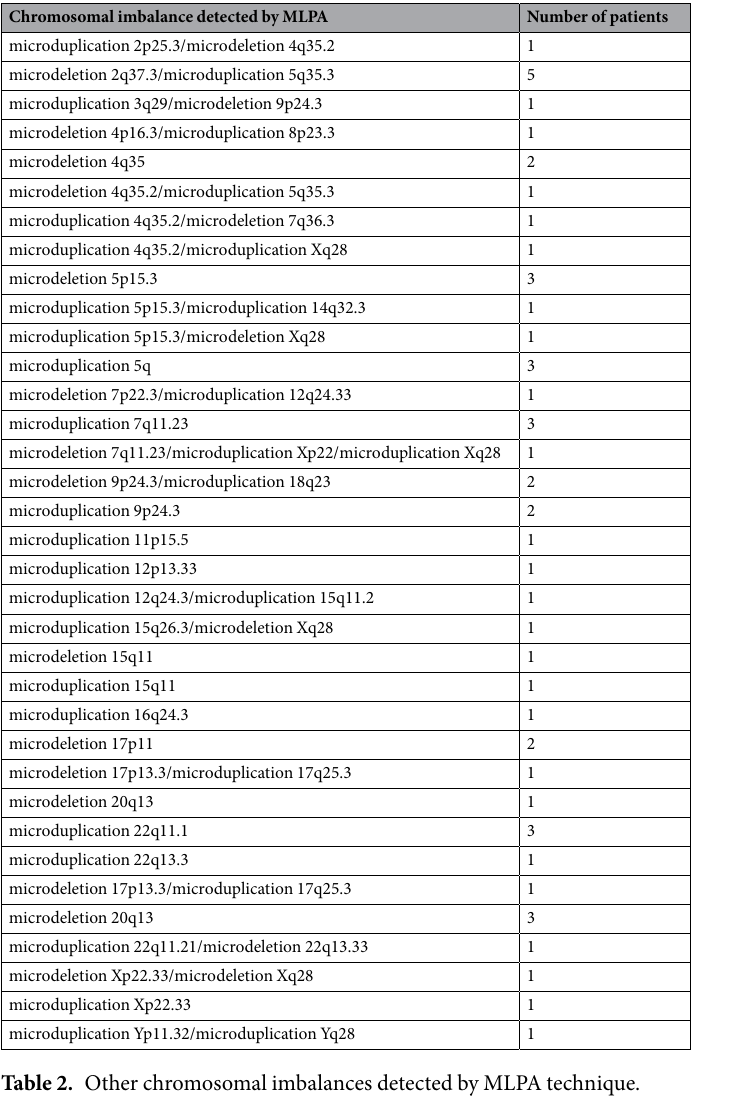
Table 2. Other chromosomal imbalances detected by MLPA